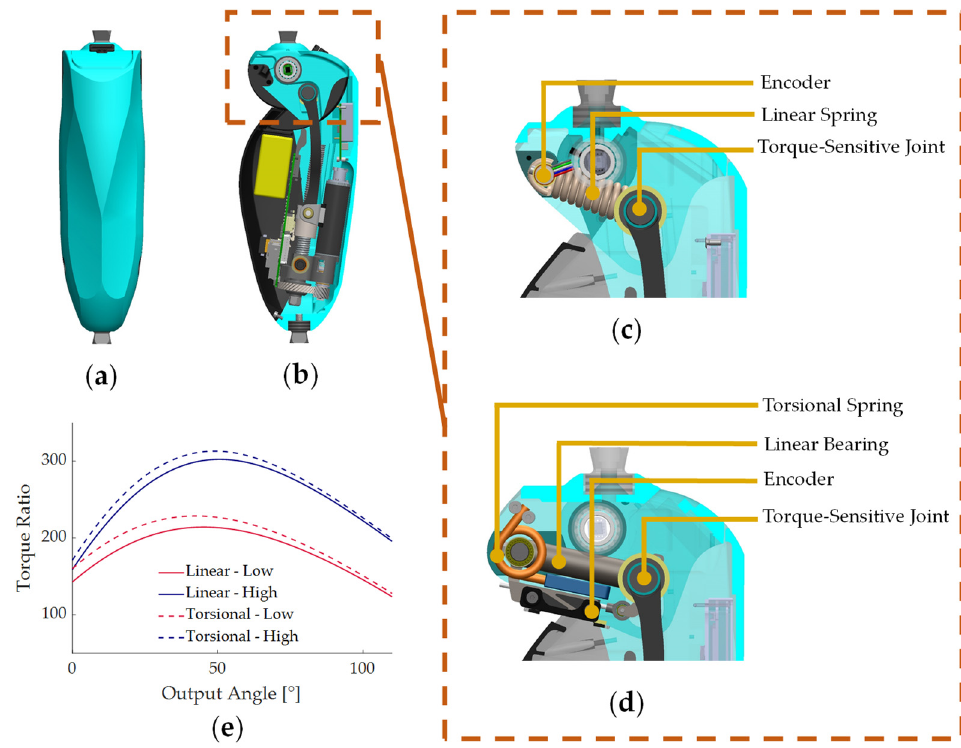
Figure 4. Mechatronic Implementation of the knee prosthesis used as a testing apparatus for this study. ( a ) Front view of the knee prosthesis. ( b ) Cross section of prosthesis side view, showing main electronic and primary transmission components. ( c ) Close-up view of the linear implementation of the torque-sensitive system. ( d ) Close-up view of the torsional implementation of the torque-sensitive system. ( e ) Range of torque ratio variation of the linear and torsional implementations.